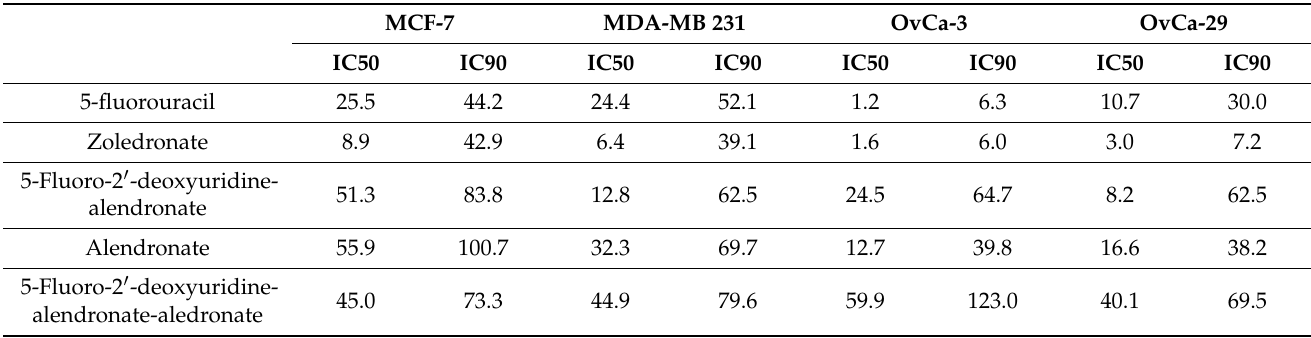
Table 5. In vitro evaluation of breast cancer cell